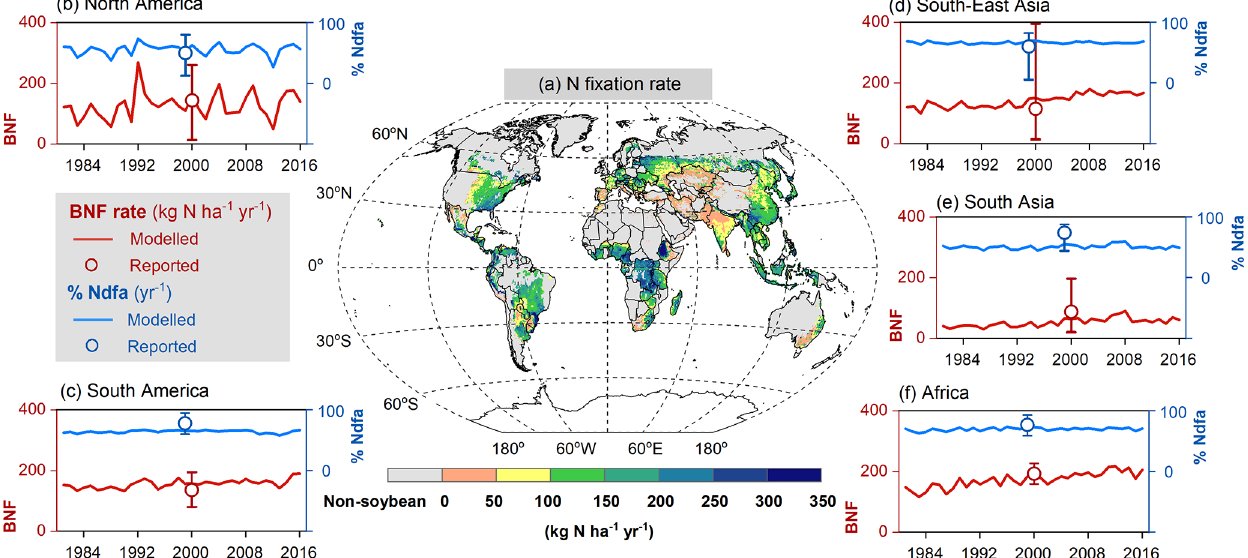
Figure 10. Map of soybean N fixation modeled by LPJ-GUESS averaged over 1996–2005 (a) and the comparison of simulated BNF rate (red line) and %Ndfa (blue line) with literature-reviewed data (open circle; Peoples et al., 2009) on a regional level (b–f) . Reported data shown in open circles do not represent specific years but the potential over time in Peoples et al. (2009); the vertical bars denote the range of estimations based on the original literature given in Table 1 in Peoples et al.